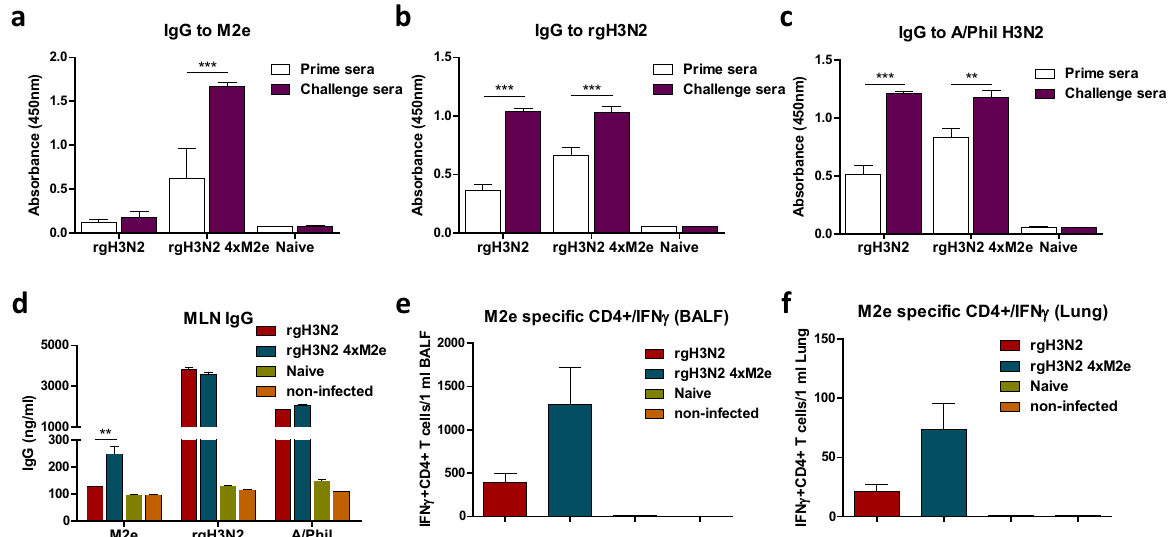
Figure 5. Single inoculation of rgH3N2 4xM2e virus effectively primes M2e and virus specific immune responses. Sera after rgH3N2 or rgH3N2 4xM2e immunization (day 14) and challenge with A/Phil H3N2 virus (50 LD 50 , day7) were collected respectively to determine IgG antibody response specific for ( a ) M2e (1:100 sera), ( b ) rgH3N2 (1:10,000 sera), and ( c ) A/Phil (H3N2) (1:10,000 sera) antigens. ( d ) In vitro production of M2e, rgH3N2, and A/Phil specific IgG antibodies in mediastinal lymph node (MLN) cell cultures. ( e – f ) Flow cytometry of intracellular cytokine staining for detection of IFN-γ secreting CD4 + T cells specific for M2e from BALF ( e ) and lung cells ( f) at day 5 ( d – f ) or 7 ( a – c ) following A/Phil challenge. IFN-γ + CD4 + T cells were presented from total BALF (1 ml) and Lung (1 ml) cells from individual mouse. Error bars indicate mean ± SEM. The statistical significances between rgH3N2 group versus rgH3N2 4xM2e group were determined using two- way ANOVA and indicated in *, P < 0.05; **, P < 0.01; ***, P < ing either anti-CD4 or anti-CD8 or both antibodies prior to infection with A/Phil (H3N2, 17 LD 50 ). Anti-CD4 (Supplementary Fig. S8a,c) or anti-CD8 (Supplementary Fig. S8b,d) antibody treatment resulted in significant weight loss (24% or 16% respectively) in the rgH3N2 group, lowering the survival rate (50% with anti-CD4, Sup- plementary Fig. S8c), compared to moderate weight loss (9.5 to 13%) in the rgH3N2 4xM2e group. Statistically significant difference was observed in the CD4 depleted but not CD8 depleted rgH3N2 4xM2e group prior to challenge, suggesting that CD4 is primarily responsible. When both CD4 and CD8 were depleted, the rgH3N2 group displayed significant weight loss and all mice reaching the humane endpoint (Fig. 6a,e). In contrast, 100% mice from the rgH3N2 4xM2e group survived with 8% body weight loss (Fig. 6a,e). These results suggest that M2e antibodies contribute to cross protection by a prime dose of rgH3N2 4xM2e regardless of T cells at the time of challenge whereas CD4 and CD8 T cells particularly CD4 T cells might play a significant role in cross protec- tion by rgH3N2. We extended the impact of both CD4 and CD8 depletion on cross protection against A/PR8 (H1N1) and PR8 reassortants with avian M2 (Fig. 6). Treatment of rgH3N2 4xM2e primed mice with CD4 and CD8 depleting antibodies resulted in 100% survival rates and approximately 13% weight loss after A/PR8 (H1N1) challenge whereas rgH3N2 primed mice showed over 20% weight loss and 0% survival rates (Fig. 6b,f). With CD4 and CD8 T cell depletion, the significant differences in weight changes and survival rates between the groups were observed after rgPR8 Mg challenge (Fig. 6c,g). While rgH3N2 4xM2e mice lost 9% of body weight with 100% survival rate, rgH3N2 mice had 20% weight loss with 20% survival rates. In consistent, the rgH3N2 4xM2e group showed significantly enhanced survival protection with less weight loss against a high lethal dose (20 LD 50 ) of rgPR8 Ms virus (M gene from A/Shanghai/2/2013, H7N9) compared to the rgH3N2 group with 0% survival (Fig. 6d,h). The weight recovery was delayed in surviving mice with CD4 and CD8 T cell depletion after challenge, suggesting an important role of T cells in recovery or preventing severe viral pathology. These results support the differential roles of CD4 and CD8 T cells and M2e specific IgG antibodies in conferring cross protection by rgH3N2 and rgH3N2 4xM2e prime immunization. Boost dose of rgH3N2 4xM2e further enhances M2e antibodies. Boost inoculation (10 6 EID rgH3N2 4xM2e) induced significantly higher levels of M2e specific IgG1 and IgG2a isotype antibodies (Fig. 7a,b) than post prime IgG antibody levels (Fig. 2a,b). Consistent with post prime, hM2e IgG antibody levels post boost with rgH3N2 4xM2e were significantly higher than those of swine M2e or avian M2e antibodies (Supplementary Fig. S3b). Both rgH3N2 and rgH3N2 4xM2e groups increased IgG isotype antibodies and HAI activity against vaccine strain rgH3N2 but not against heterologous viruses including A/PR8, A/Phil, and rgH5N1 (Supplemen- tary Fig. S9a, b, c) compared to prime sera.